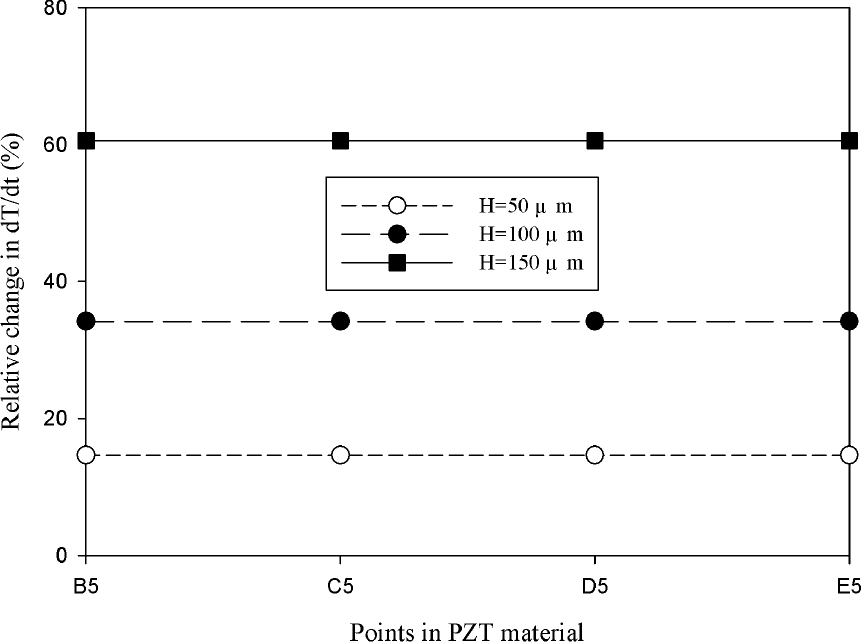
Figure 15. Simulated relative change in the maximum peak value of the temperature variation rate at points B5, C5, D5 and E5 for the mesh top electrode with cavities in the PZT material, compared with that at point A5 for the fully covered electrode, with an electrode width of 500 μ m and various etching depths of 50, 100 and 150 μ